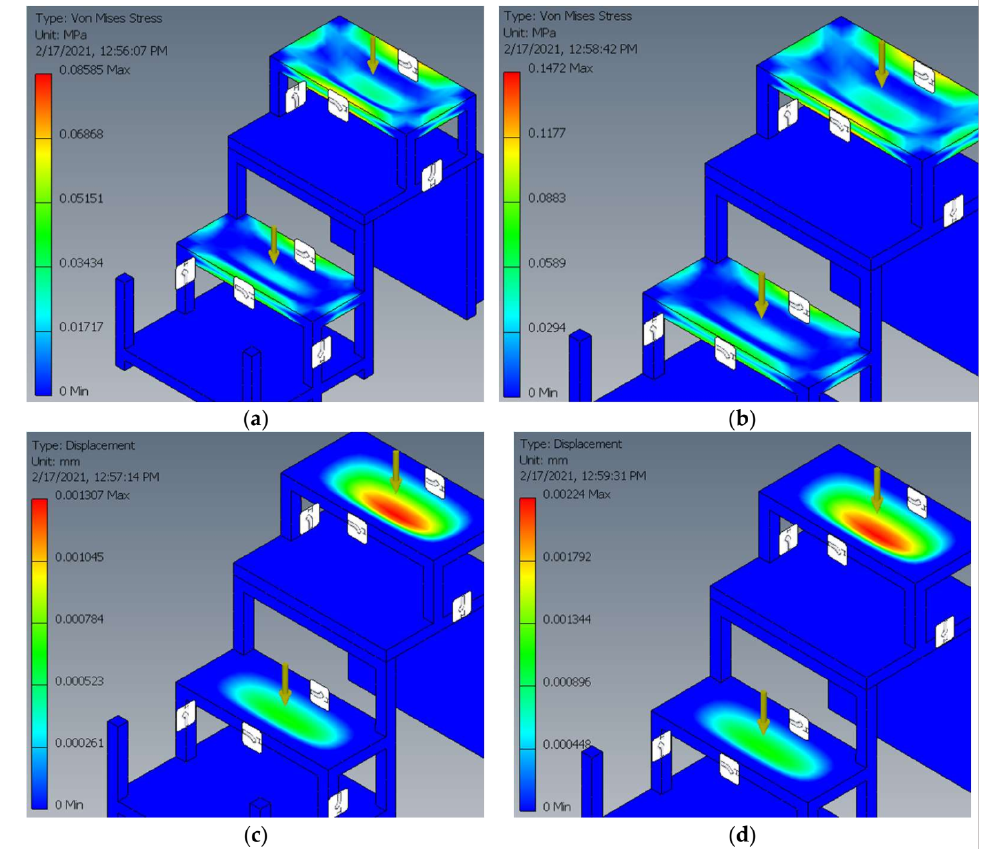
Figure 11. Von Mises stress and displacement simulation results for invention in stepladder- transformed state when applying weights of 70 kg and 120 kg. ( a ) Von Mises stress simulation for 70 kg, ( b ) Von Mises stress simulation for 120 kg, ( c ) Displacement simulation for 70 kg, ( d ) Dis- placement simulation for 120